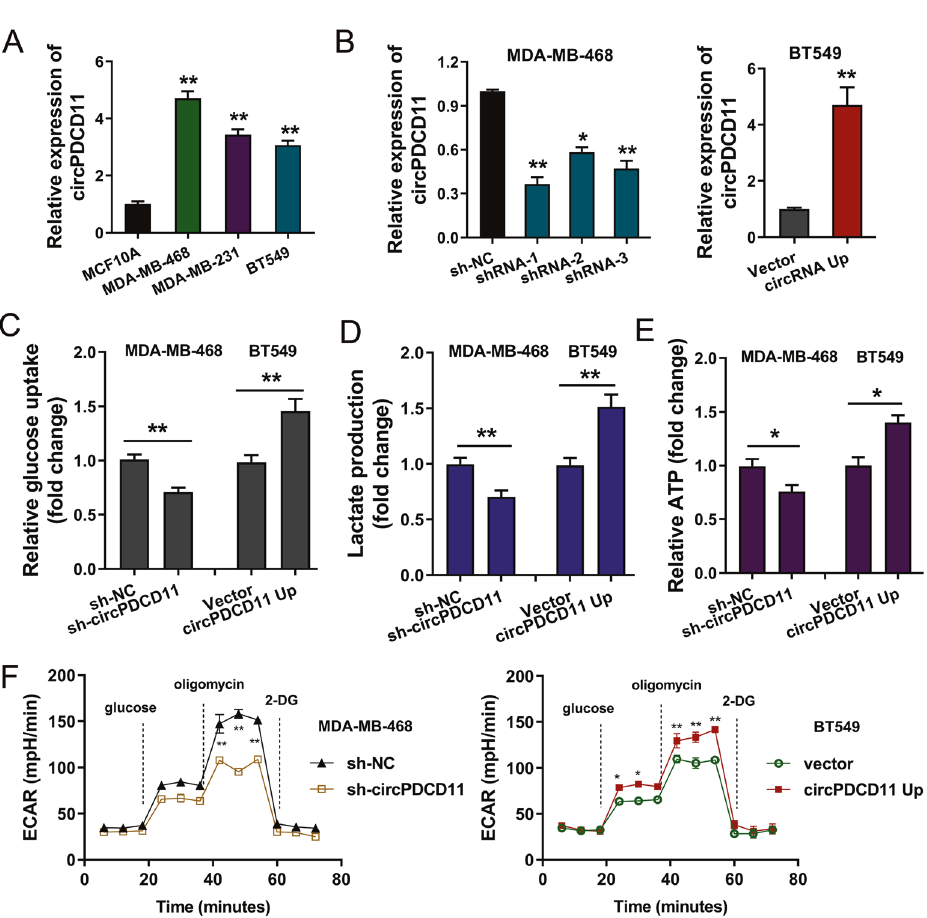
Fig. 2 circPDCD11 enhanced aerobic glycolysis in TNBC cells. A RT-qPCR demonstrated circPDCD11 expression as measured in TNBC cell lines (BT549, MDA-MB-468, and MDA-MB-231) and human normal breast cells (MCF10A). B Lentivirus-mediated small-hairpin RNA (shRNA) and plasmid transfection were performed to effectively downregulate (MDA-MB-468) or upregulate (BT549) the endogenous expression of circPDCD11. C Glucose uptake was assessed using the Glucose Uptake Colorimetric Assay Kit. D Lactate-production analysis was quanti fi ed using a Lactate Colorimetric Assay Kit. E ATP quantity was quanti fi ed using the CellTiter-Glo Luminescent Cell Viability Assay Kit. F The extracellular acidi fi cation rate (ECAR) was quanti fi ed using a Bioscience XF96 Extracellular Flux Analyzer. The data are presented as the mean ± SD. Asterisks indicate signi fi cant differences (** p < 0.01, * p <